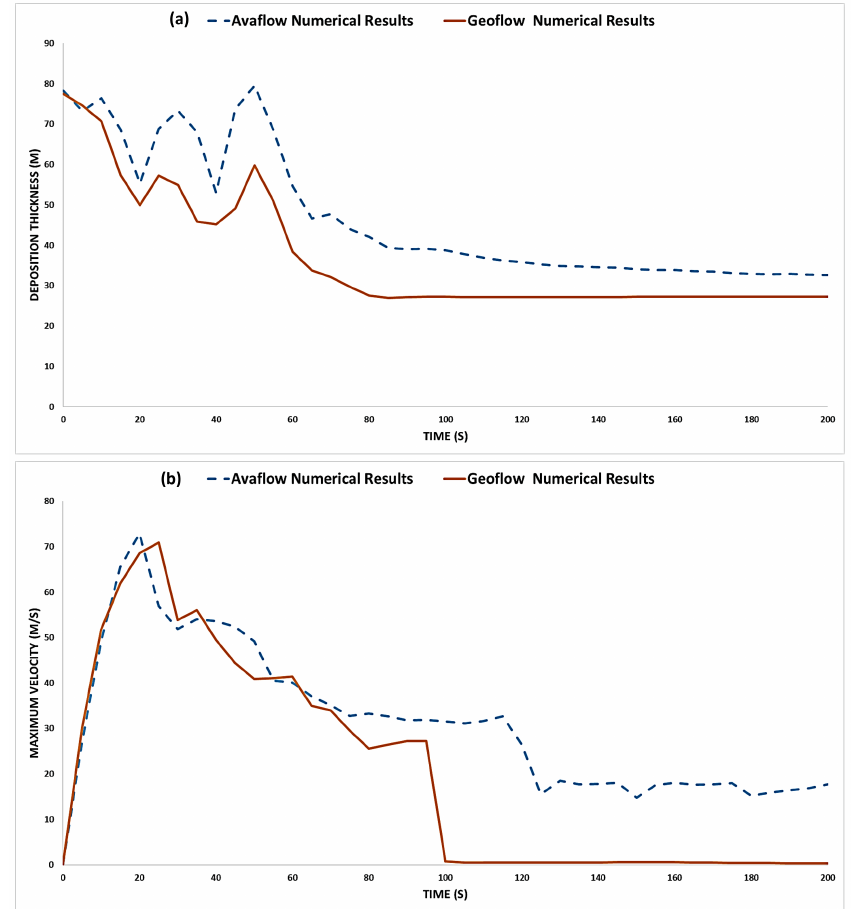
Figure 6. Comparison of the numerical results of ( a ) the maximum deposition thickness and ( b ) the maximum velocity obtained from the r.avaflow and GeoFlow-SPH